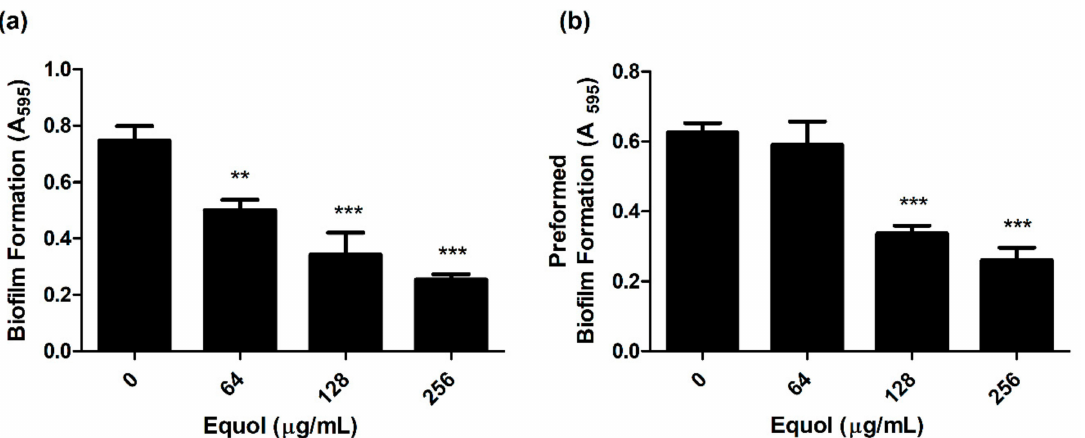
Figure 2. Anti-biofilm effect of equol against carbapenem-resistant E. coli . Biofilm inhibition ( a ) and biofilm eradication ( b ) of E. coli KBN12P05816 were quantified using crystal violet staining. E. coli was grown in TSB. The biofilm biomass was measured by the absorbance at 595 nm. Asterisks (*) indicate statistically significant differences (** p < 0.01, and *** p < 0.001) from the